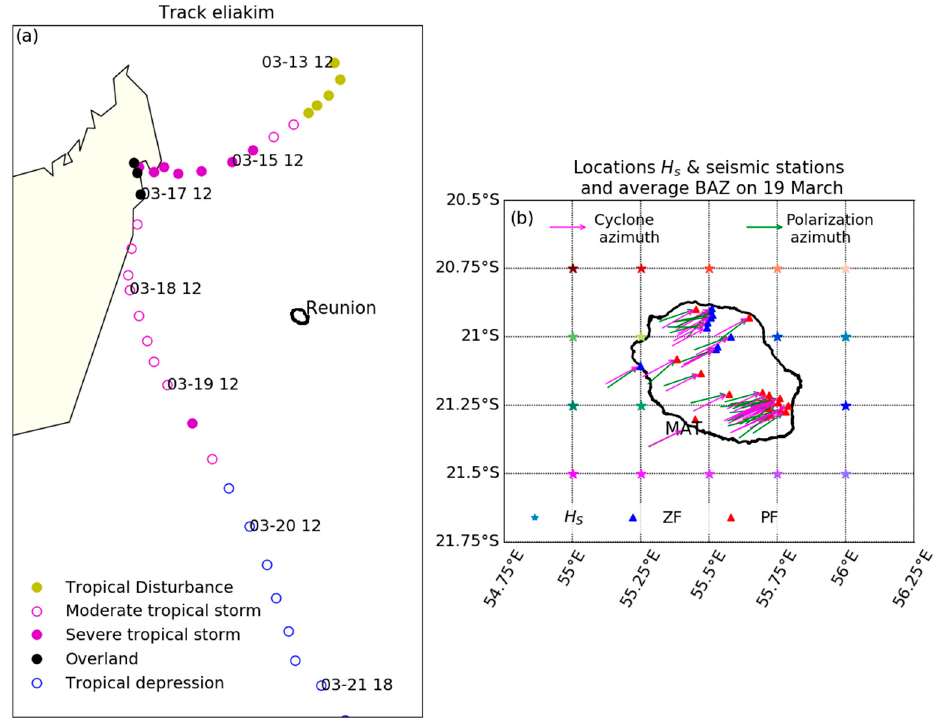
Figure 6. ( a ) Track of TS ELIAKIM as derived from RSMC La Réunion best-track data. The colored circles indicate the position and intensity of the storm every 6 h. ( b ) Locations of the seismic stations (blue triangle, temporary ZF network, and red triangle, permanent PF stations) and WaveWatch3 nodes [96] surrounding the island, where wave height Hs (colored stars) is extracted. Vectors indicate the average azimuth on March 19, 2018, obtained from the polarization analysis in the SM frequency band (green) and computed from the storm track and the RER seismic station (pink).